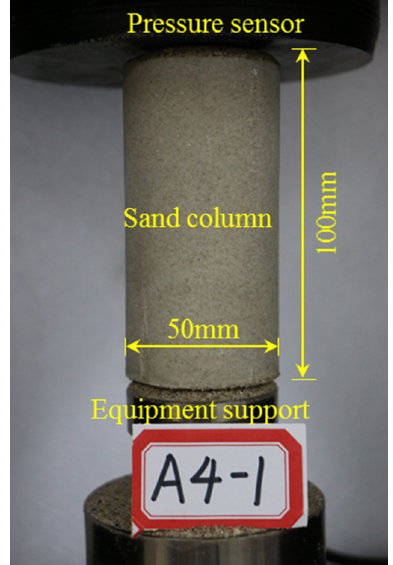
Figure 4. Setup of unconfined compression test.